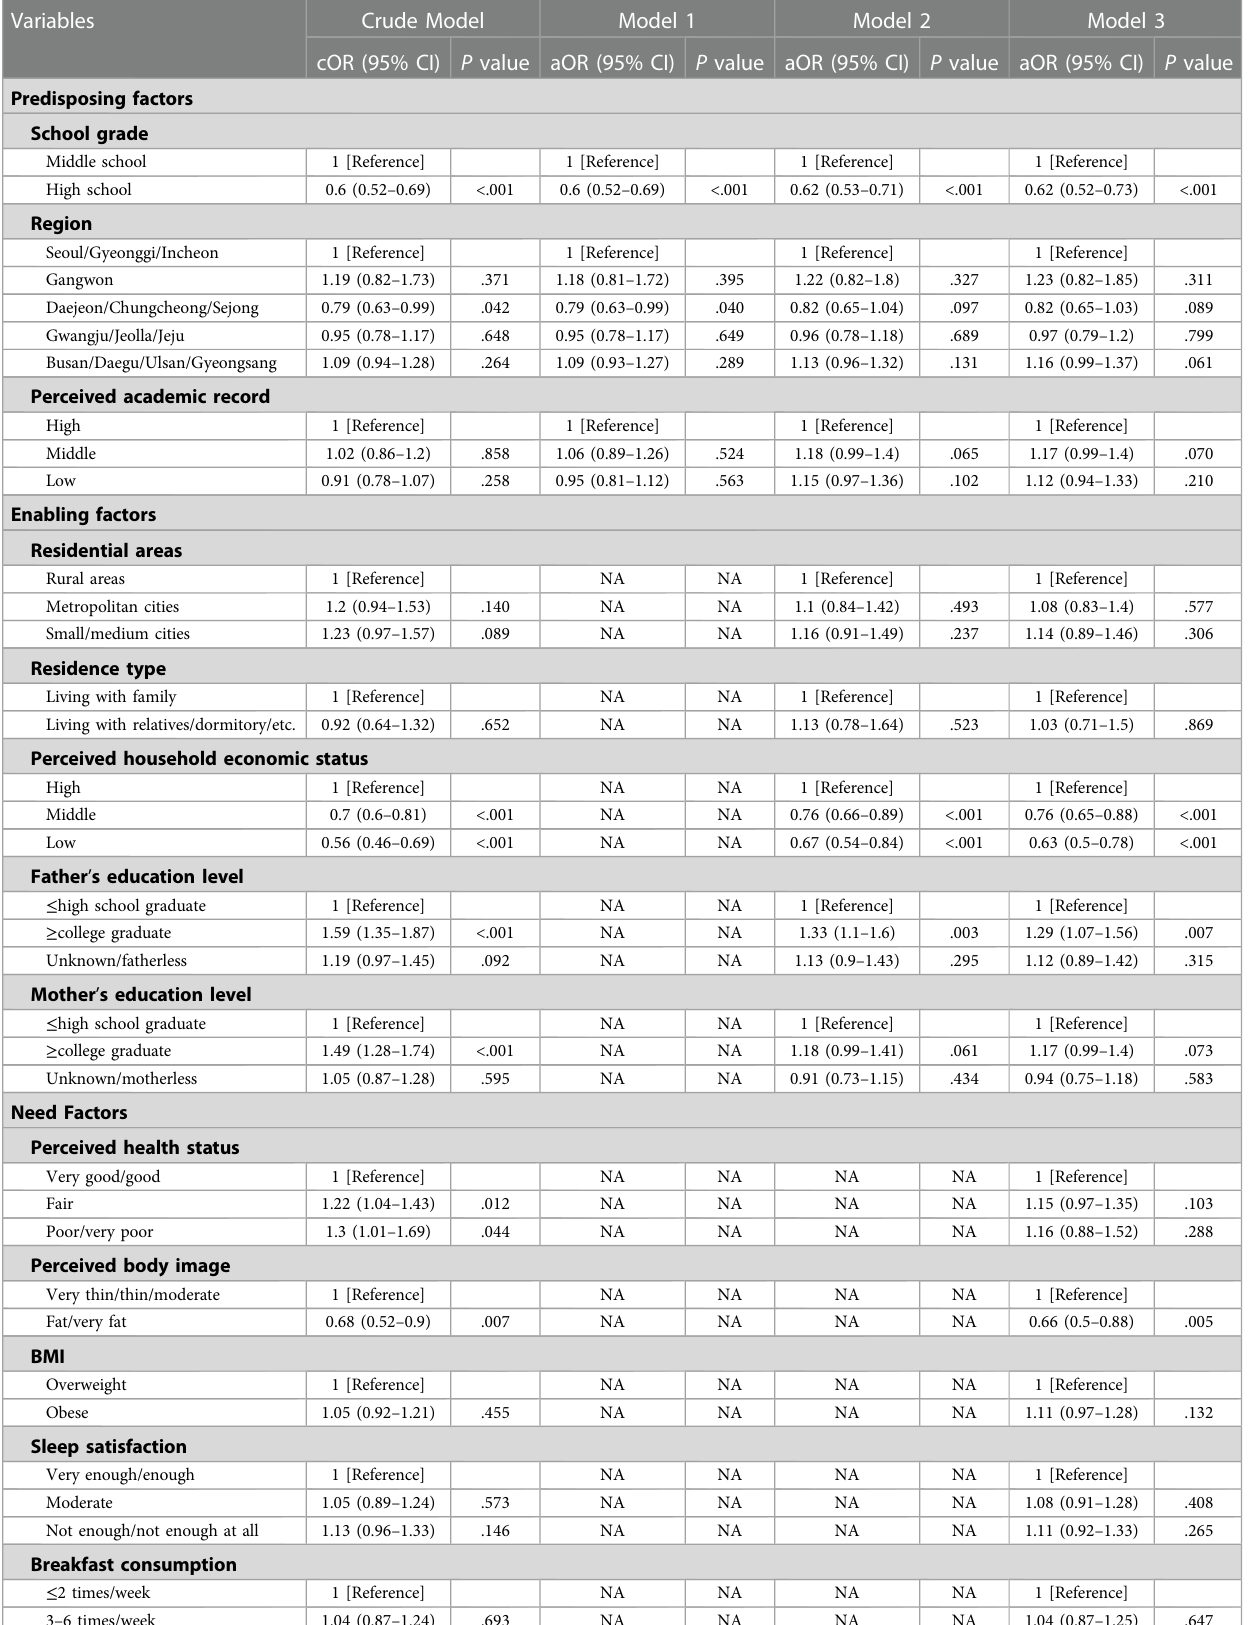
TABLE 2 Association of herbal medicine use with predisposing, enabling, and need factors in male students.